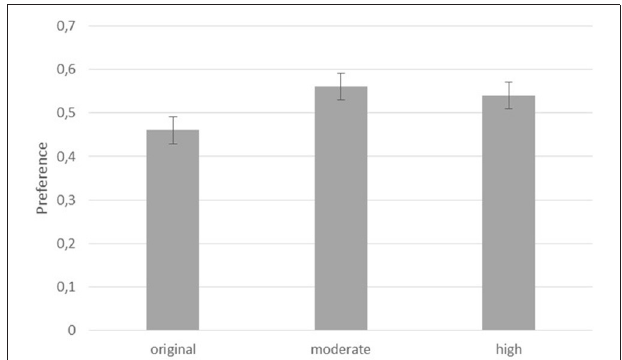
FIGURE 1 | Proportions of preferred paintings per condition.